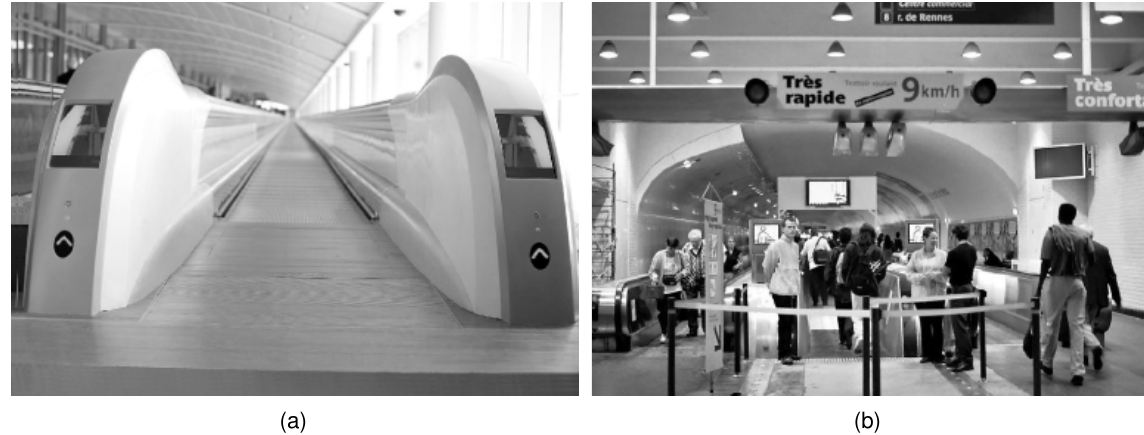
Figure 5. Accelerating moving walkway real implementations. (a) TurboTrack, Toronto airport, Canada, and (b) Gateway Paris subway, France. Adapted from Gonzalez Alemany et al. (2007), and Gautier